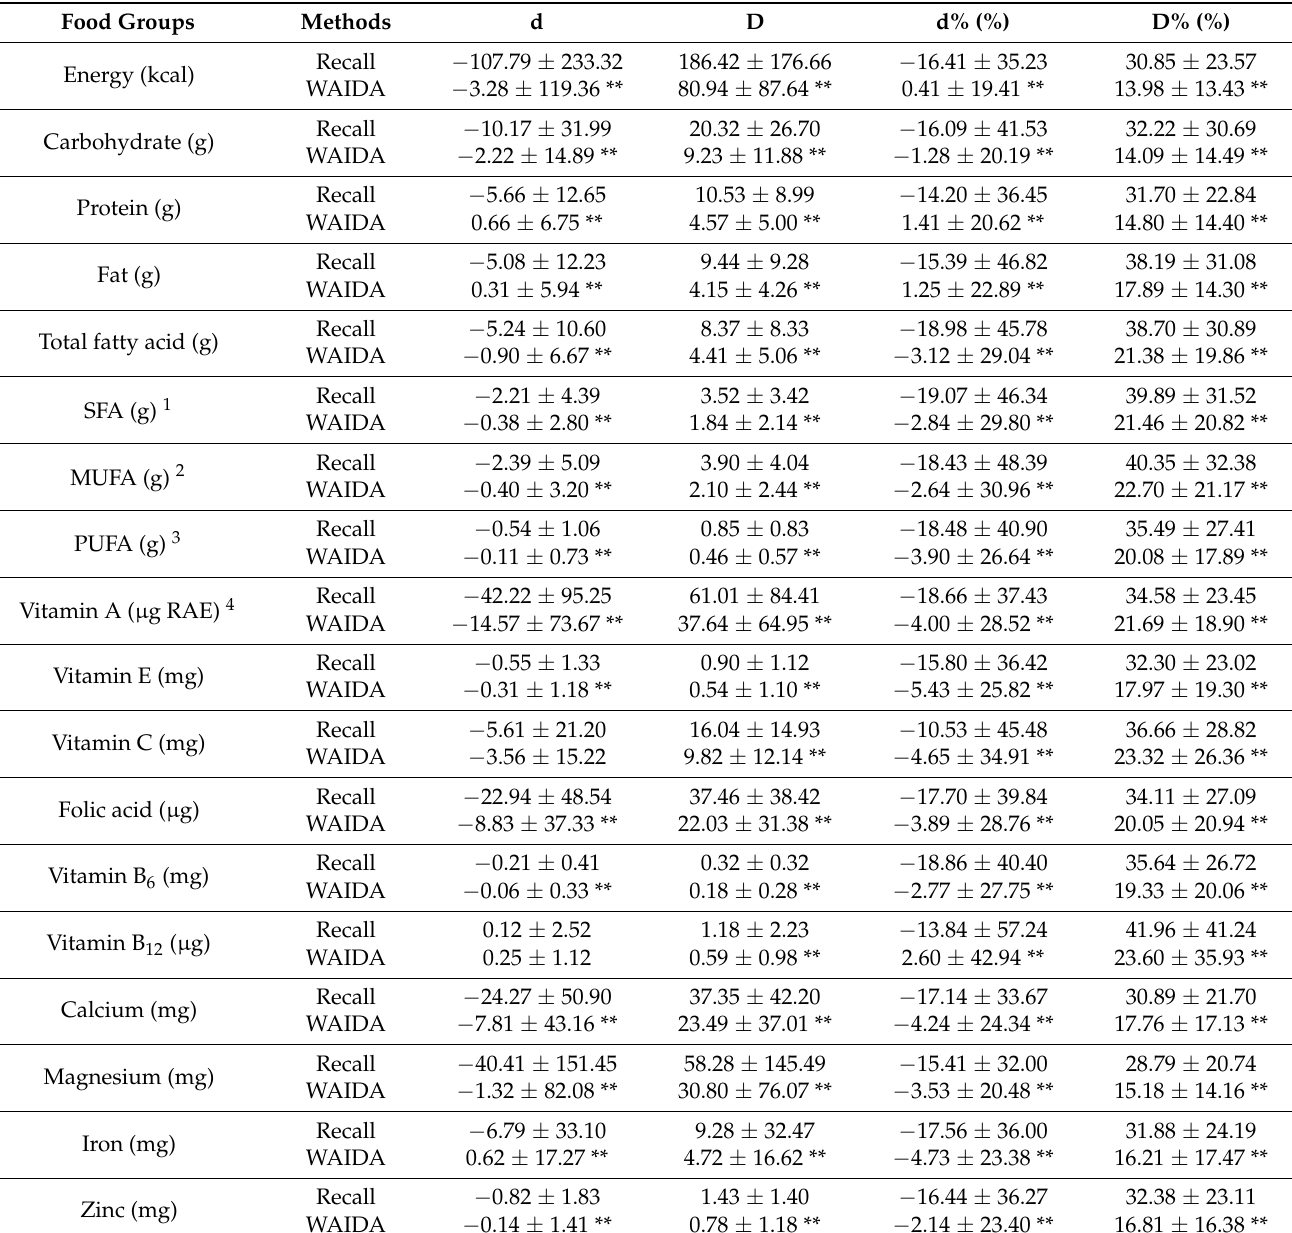
Table 3. Comparison of energy and nutrient intakes derived from the recall or WAIDA method with the weighing method ( n = 251 meals, Mean ±